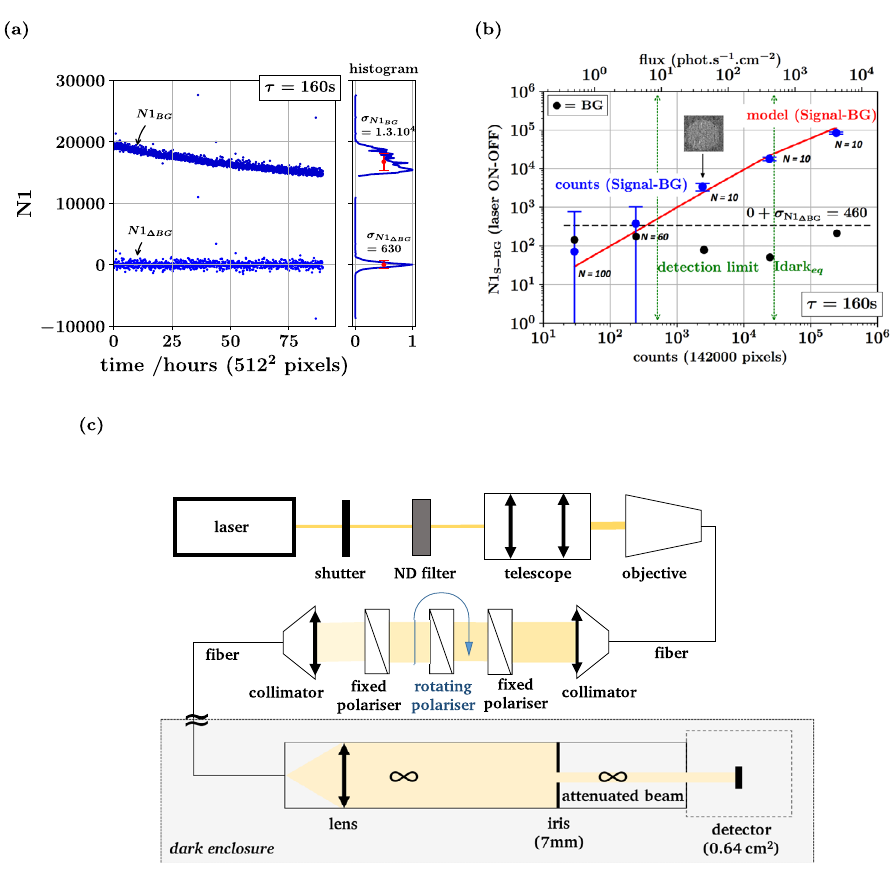
Figure 4. Experimental set-up and response to ultraweak calibrated fluxes. The camera cooling temperature 3 . Neither cosmic rays nor outlier pixels 3 count/s pixel, and p 1.7 10 1.13 10 is – 74 °C, I d CIC = − − × = × are discarded. ( a ) Shows the count number N 1 (top trace with blue dots) measured in complete darkness over 90 h with all pixels τ = 160 s. The bottom trace (blue dots) corresponds to the difference (cid:31) N 1 between successive values of N 1 . Side histograms show the dispersion of both signal traces. ( b ) The difference signal (cid:31) N 1 is measured with a τ = 160 s exposure time in the presence of a calibrated light flux injected as disk of 142000 pixels around the camera center (see inserted image). The average values (cid:31) N 1 are shown (blue N T = dots and error bars) for 5 values of the photon flux (see “Materials and methods” section), together with the standard error of the mean. The black dots ( ) correspond to the average (cid:31) N 1 with the laser off. The black • 460 ) extrapolated from ( a ) ( 630 for 512 2 dotted line represents the detector noise, i.e. the standard deviation ( ≈ 142 10 4 pixels. The red line indicates the response expected from the model. The horizontal pixels) for N T = × 1 cm 2 ), and also 1 ( 9.2 photon s axis is marked (green arrows) with the photon flux that provides SNR − =